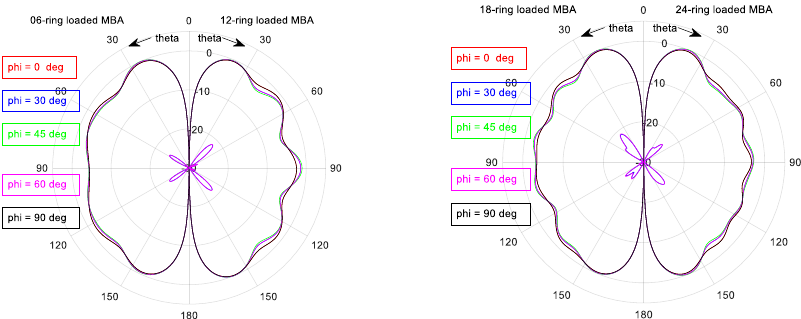
Figure A2. 2D patterns at 7 GHz of 6-, 12-, 18- and 24-ring-loaded MBA in different cutting planes.